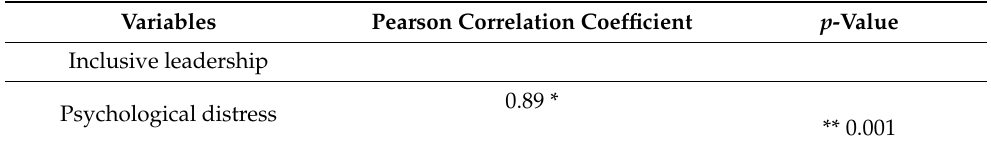
Table 6. Correlation between inclusive leadership as perceived by staff nurses and their psychologi- cal distress.